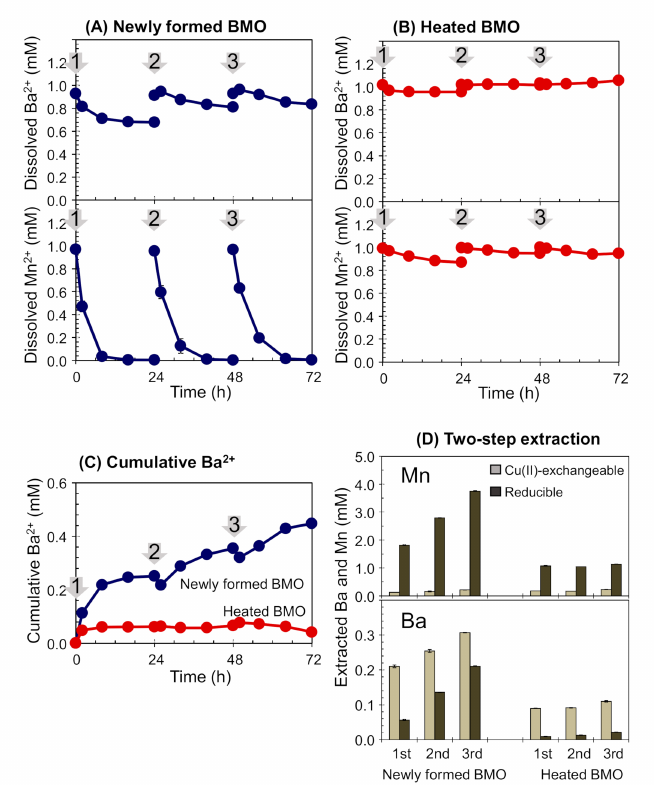
Figure 1. Illustration of the repeated treatment of the ( A ) newly formed and ( B ) heated biogenic manganese oxides (1 mM Mn) with mixtures of 1 mM Ba(NO 3 ) 2 and 1 mM Mn(NO 3 ) 2 in 20 mM 4-(2- hydroxyethyl)–1–piperazineethanesulphonic acid (HEPES) (pH of 7.0). ( C ) Cumulative concentration of the sequestered Ba 2+ and ( D ) exchangeable and reducible Ba and Mn in the solid phases, assessed via the two-step extraction. Bathing solutions were renewed every 24 h (indicated by